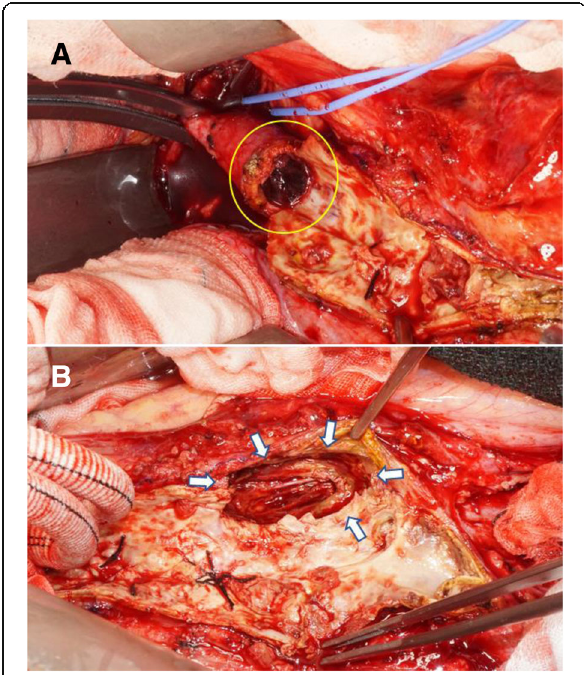
Fig. 4 Operative findings. a Intraluminal thrombus of the abdominal aorta (ring). b Punched-out large defect on the posterior wall